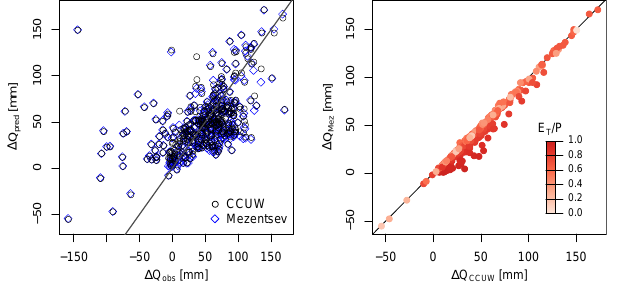
Fig. 5. Left: Scatterplot of observed vs. predicted annual average changes in streamflow for MOPEX dataset without stations with missing data. The vertical difference to the 1 : 1 line depicts the deviation of the prediction to the observed value. Right: predicted change in streamflow due to climatic changes, comparing the es- timates of the Budyko framework with the CCUW estimates. The colour of the dots represents the evaporation ratio E T / P